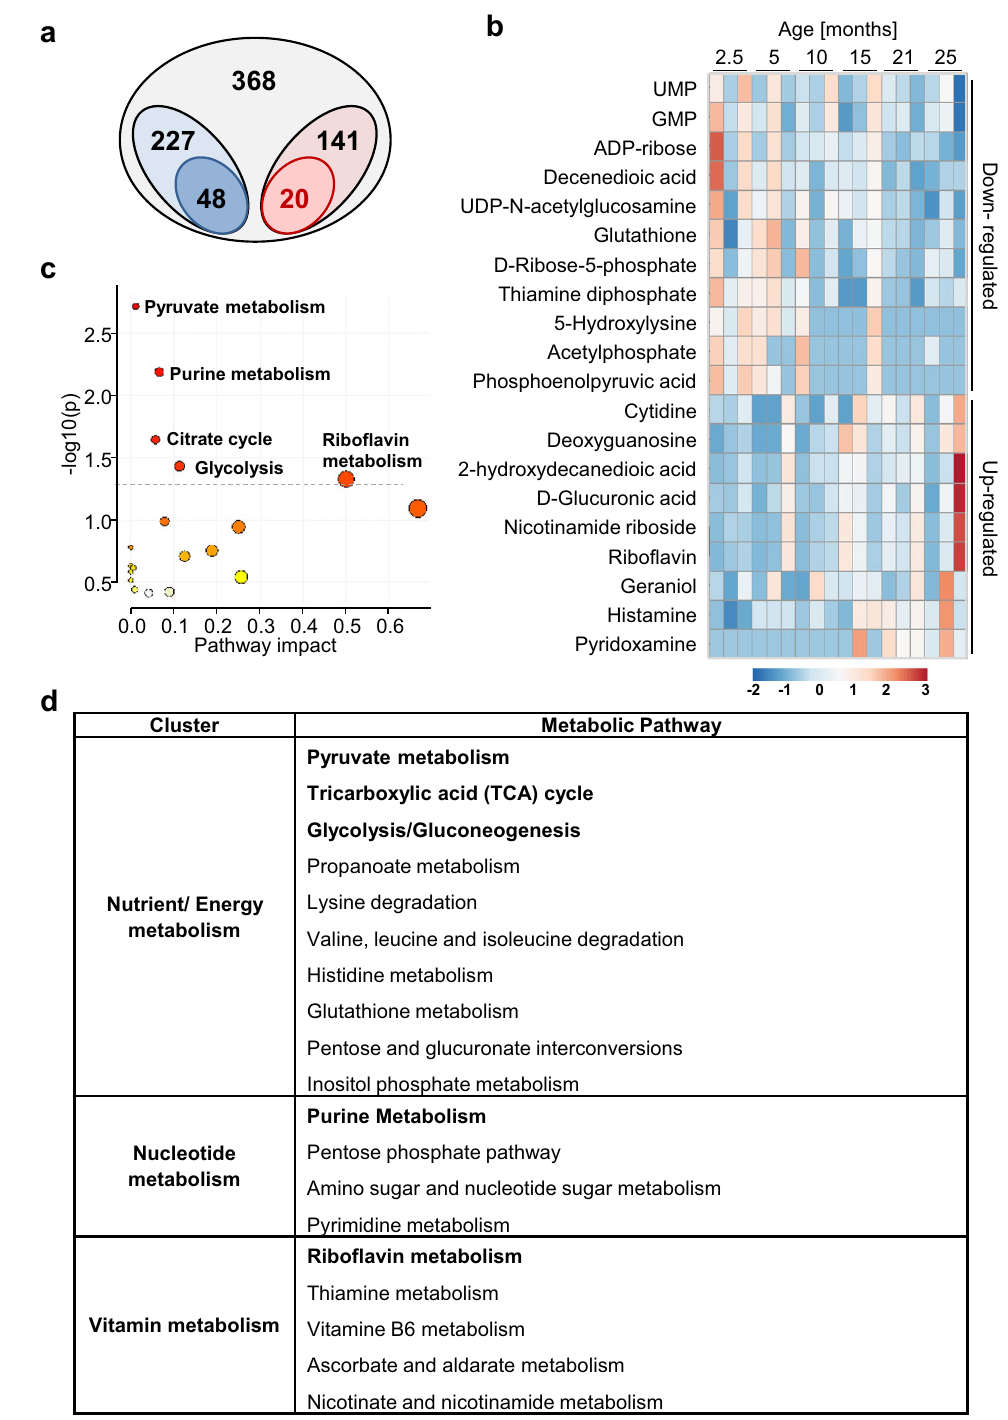
Figure 1. Changes of polar metabolites during BAT-aging. ( a ) Venn diagram representing metabolites from BAT samples that were collected from animals aged 2.5, 5, 10, 15, 21, and 25 months (n = 3/ age-group). All metabolites were detected by LC–MS and GC–MS metabolomic analysis. 368 compounds were detected (light grey) and grouped into non-polar lipid species (227 candidates; light blue) and polar metabolites (141 candidates; light red). For each group, clusters of metabolites with significant correlation to aging across the age-groups were identified, corresponding to 48 non-polar lipid species (dark blue) and 20 polar metabolites (dark red). ( b ) Heatmap representing concentrations of the 20 individual polar metabolites that were significantly correlated to BAT-aging in the individual animals from each age group. ( c ) Pathway enrichment analysis for the 20 polar metabolites with significant age-related correlation using MetaboAnalyst software. Grey line indicates formal threshold of significant enrichment. ( d ) Summary of all pathways identified from the enriched polar metabolites, including pathways with significant enrichment (bold; p < 0.05), after grouping into three functionally related sub-clusters, i.e. (1) nutrient/ energy metabolism, (2) nucleotide metabolism, and (3) vitamin